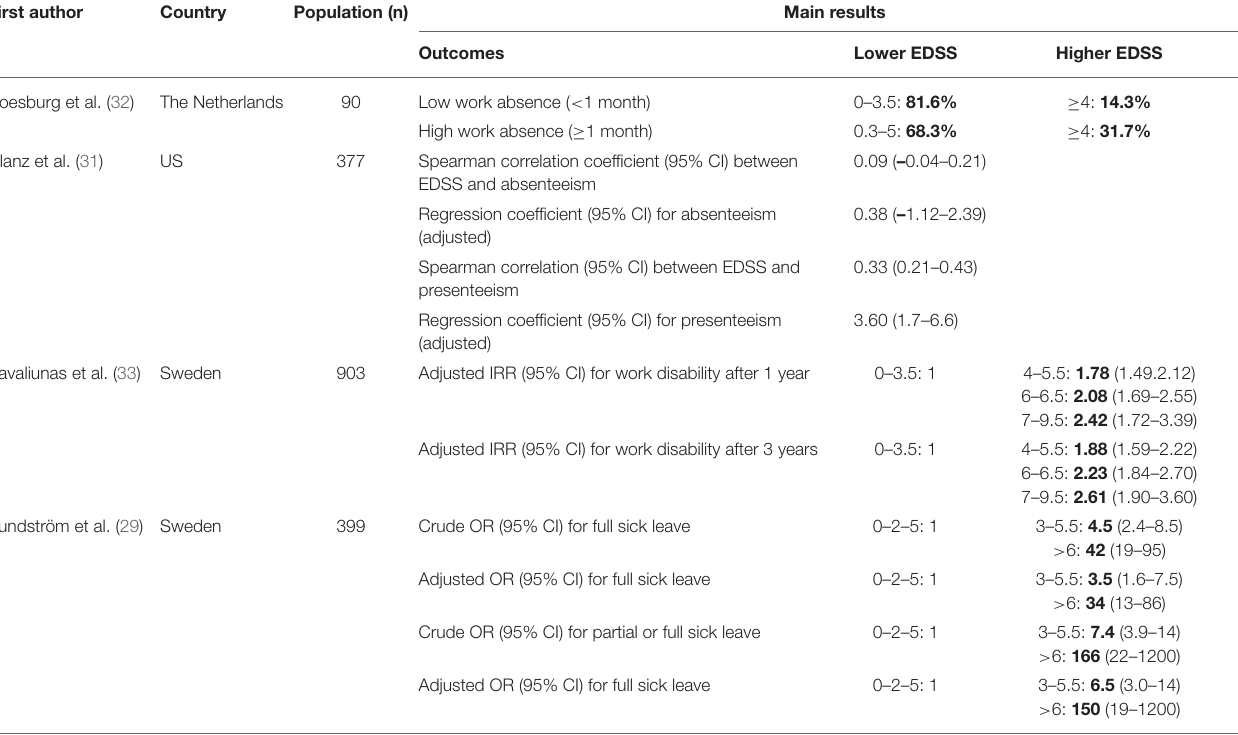
TABLE 6 | Studies that investigated work ability-related outcomes in patients with MS within different levels of physical